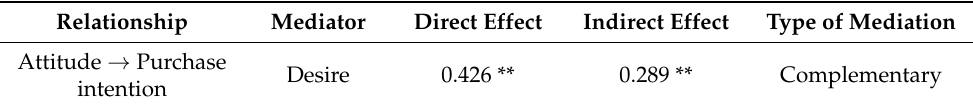
Table 6. Analysis of the mediation